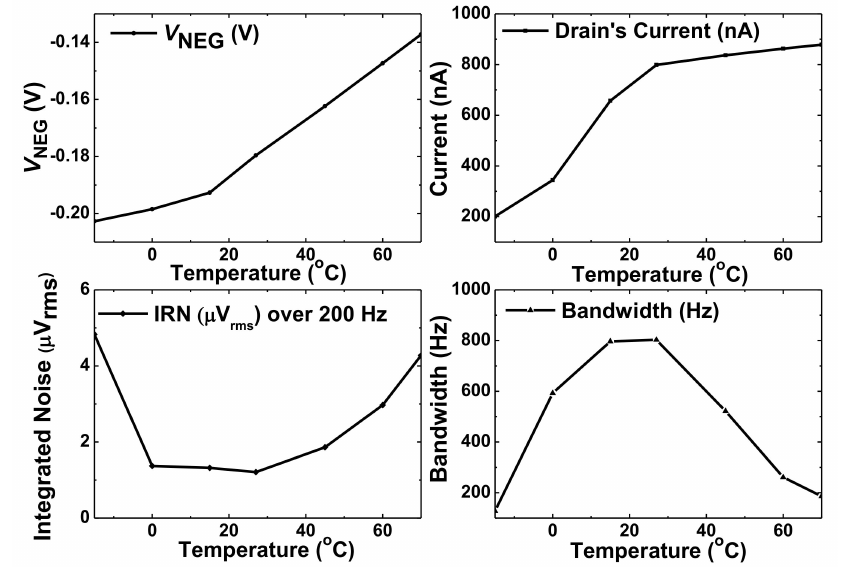
Figure 11. Simulated bias current, noise, and bandwidth depending on